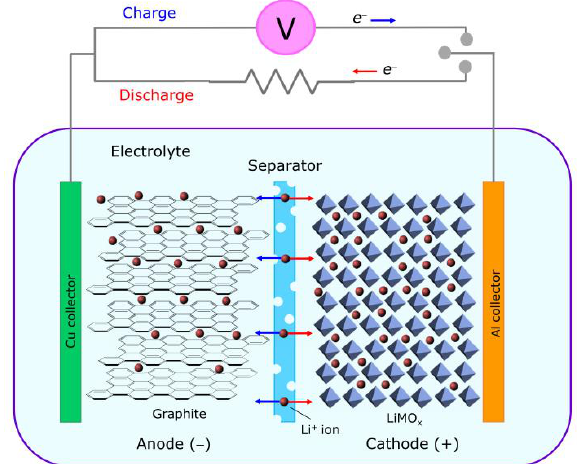
Figure 4. Schematic illustration of a traditional lithium-ion battery (LIB) cell [62,63]. Li + ions migrate through the electrolyte, and electrons flow through the external circuit. De-lithiation reaction (charge process): C x + LiMO 2 → Li (1-y) MO 2 + C x Li y ; lithiation reaction (discharge process): Li (1-y) MO 2 + C x Li y →